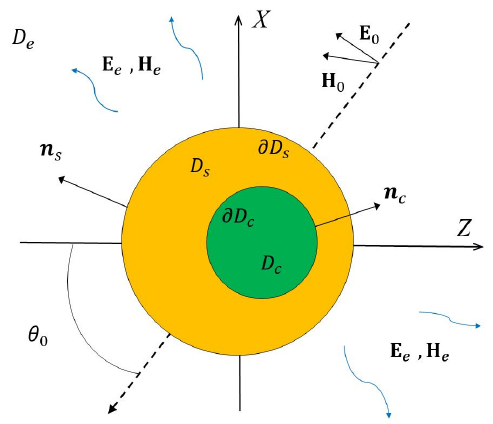
Figure 1. Core-shell particle illuminated by the plane wave { E 0 , H 0 }